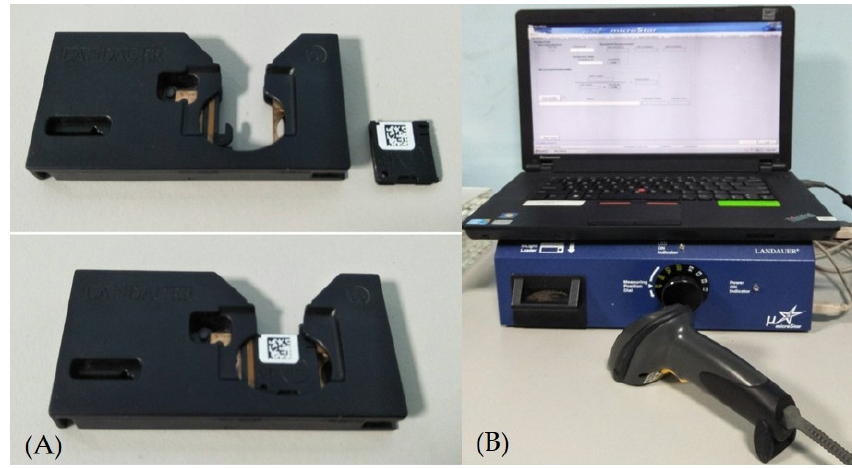
Figure 3. OSLD dosimetry system: ( A ) nanodot OSLDs; ( B ) microStar